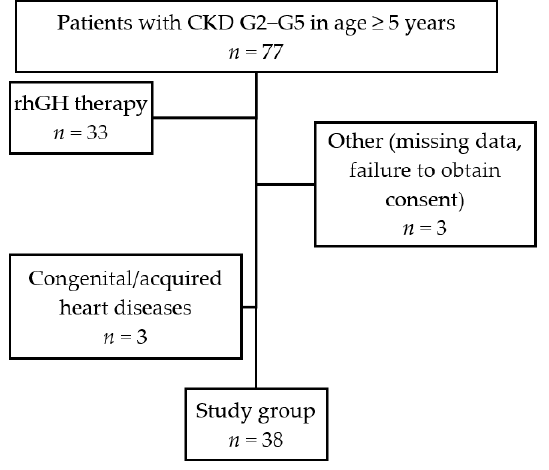
Figure 1. Flowchart of the patients’ recruitment (CKD—chronic kidney disease, G—Grade, rhGH— recombinant human growth hormone).